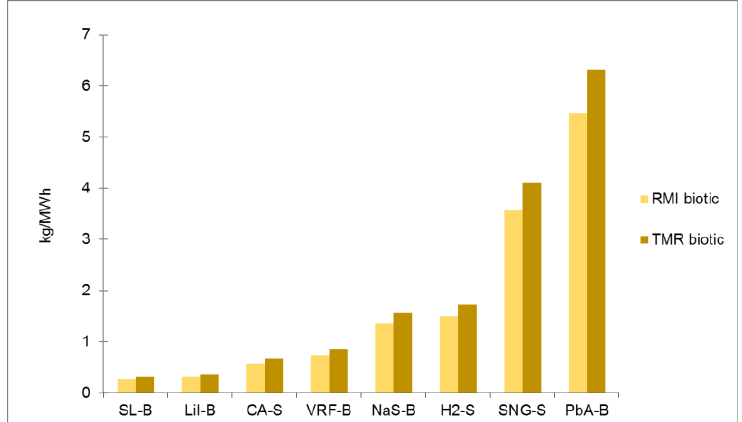
Figure 4. Raw material input biotic RMI biotic and total material requirement biotic TMR biotic per fed-out electricity of electrical energy storage technologies.